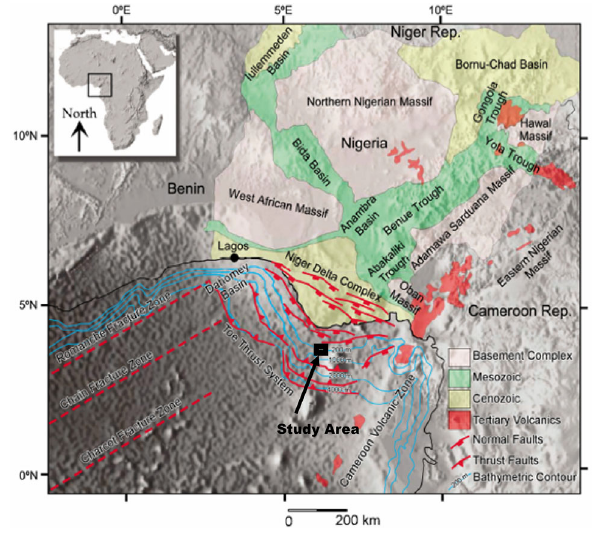
Fig. 1 Map of the Niger Delta showing study location (After Corredor et al.